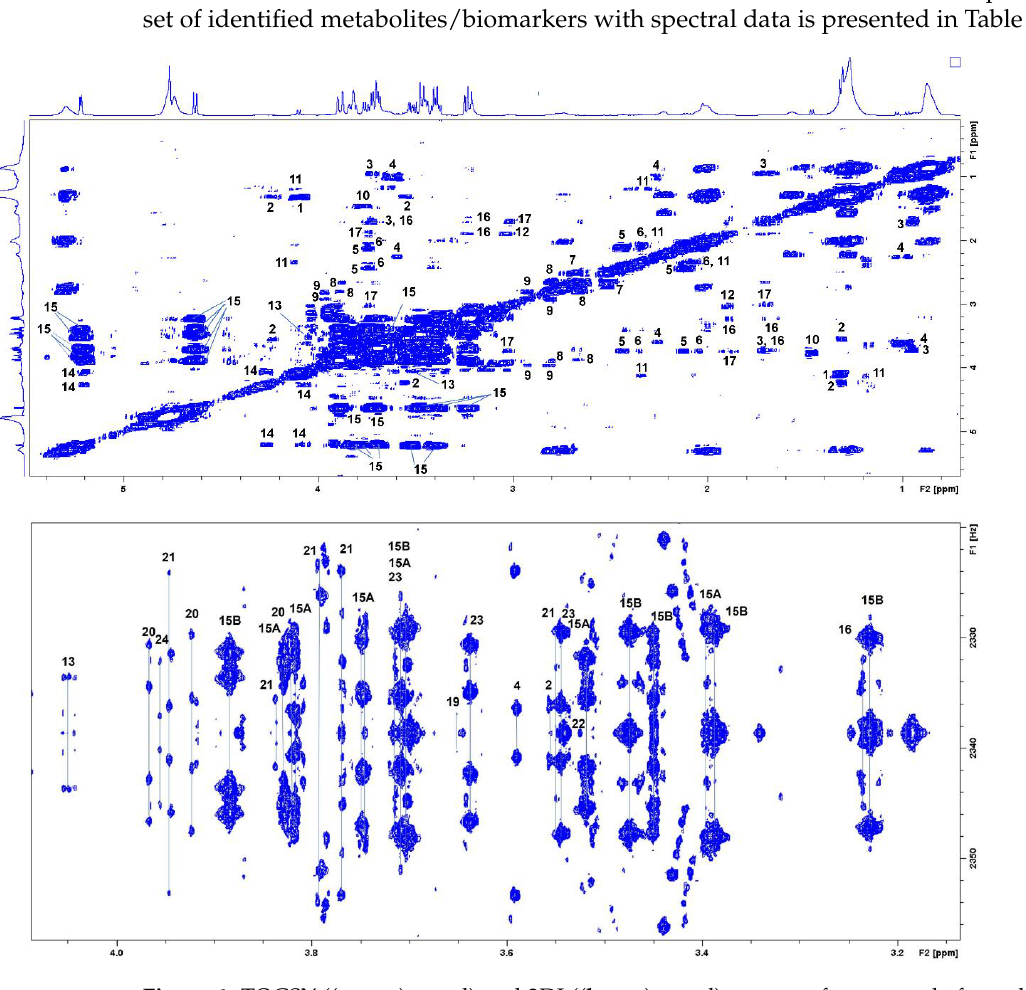
Figure 6. TOCSY (( upper ) panel) and 2DJ (( lower ) panel) spectra of one sample from the Serbian cohort of schizophrenia patients in 0.7–5.5 ppm and 3.1–4.1 ppm, Table 2. Metabolites/biomarkers identified in schizophrenia patients ’ serum samples, with spectral data.